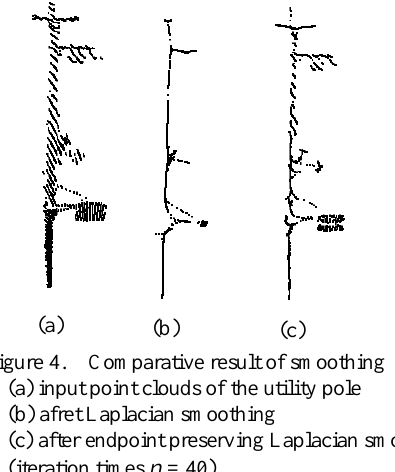
Figure 4. Comparative result of smoothing